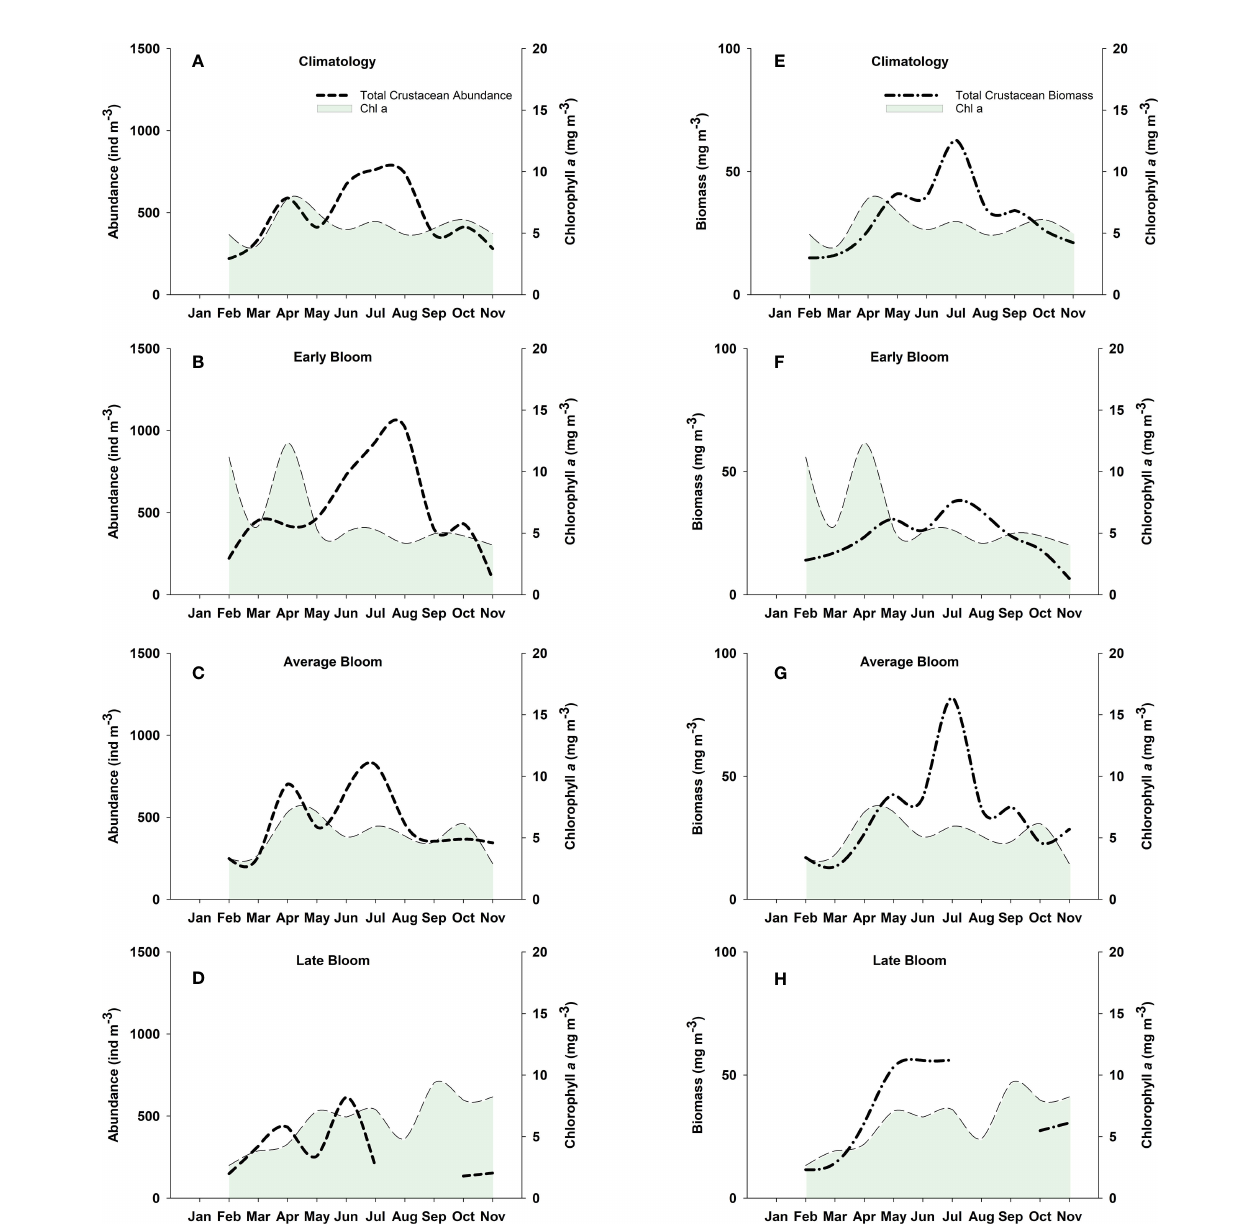
FIGURE 4 | Monthly Chl a and total crustacean abundance (left panels) and biomass (right panels) during climatological years (2003-2016; A, E ), and during early (2004, 2005, 2015; B, F ), average (2003, 2006, 2009-2014, 2016;) (C,G) , and late (2007, 2008; D, H ) Chl a bloom years in the Central Strait of Georgia,